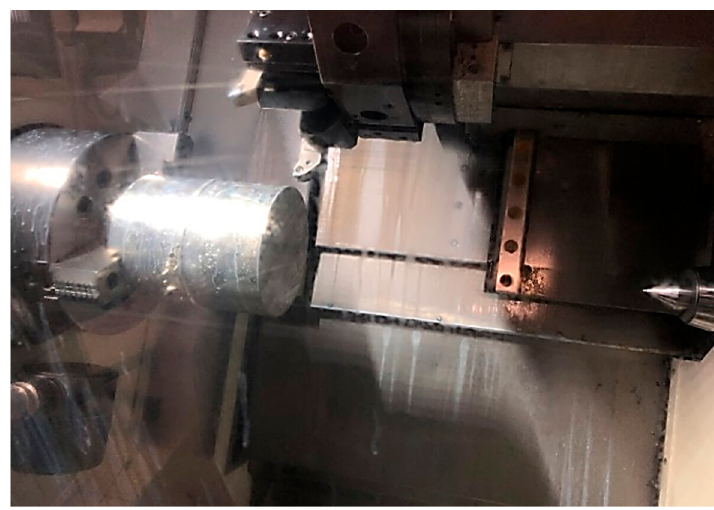
Figure 1. Working zone of the DMG Mori eco Turn 450 turning center. T (Tool); the tool consists of a tool holder (TH) and a cutting insert (TCI). Cutting inserts DCGW 11T308 were used for the experiments. The standard dimensions of the insert according to the standard ISO are length 19.65 mm and height 3.97 mm. The diameter of the insert in the axis is 9.525 mm. The changeable cutting inserts made of super hard cutting materials are manufactured in two layers. A disk of polycrystalline diamond is brazed onto the carbide substrate. The disk contains a brazed tip made of the material PCD-CTB 010 with a length of 2.77 mm and a depth of 1.6 mm. The corner radius is 0.8 mm and the tip angle is 55, as shown in the AutoCAD model in Figure